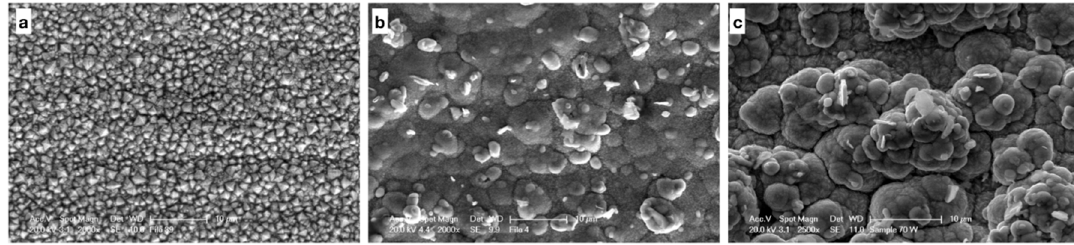
Figure 2. Scanning electron microscopy images ( a ) Ni magnification 2000 × , ( b ) Ni + MoS 2 magnification 2000 × , and ( c ) Ni + WS 2 magnification 2500 × .